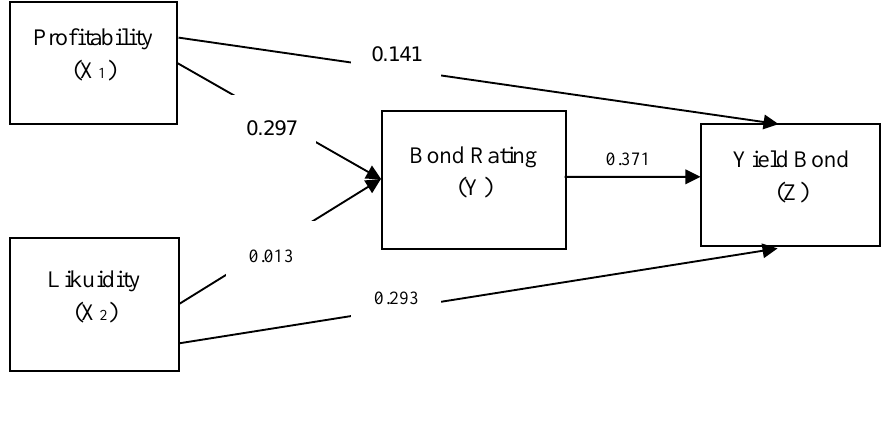
Figure 3: Result of Path Analysis Second